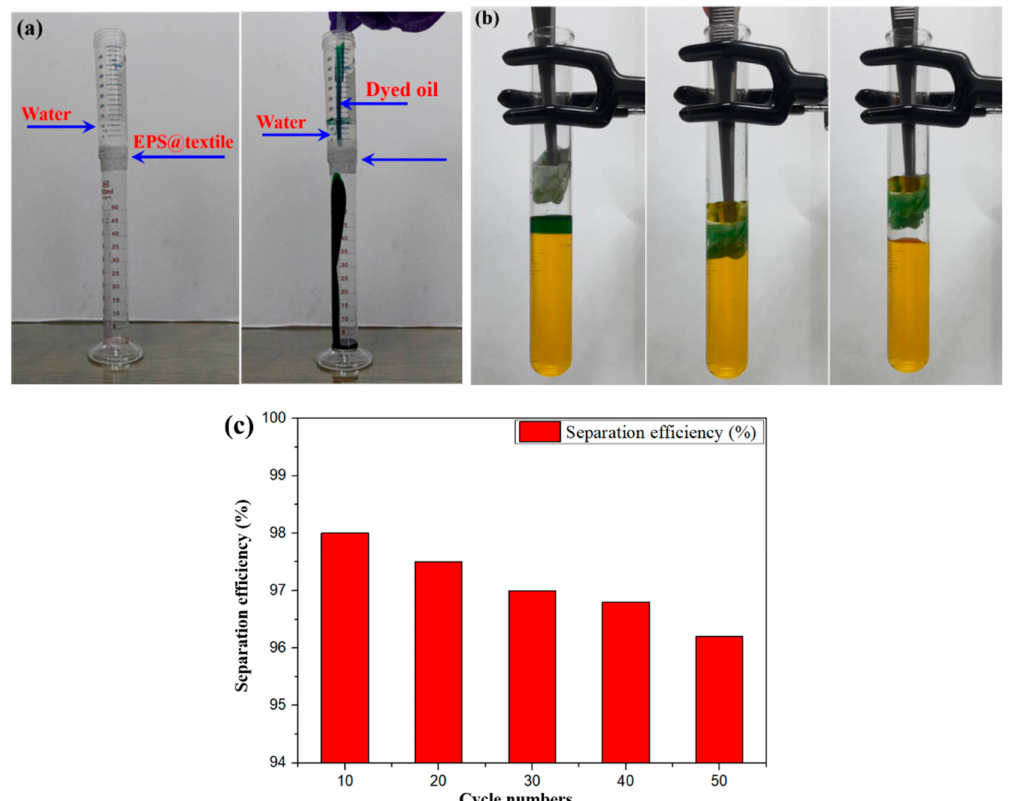
Figure 4. The optical photographs of oil/water separation using a fabric coated with EPS@textile as ( a ) filtering membrane and ( b ) adsorbent; ( c ) durability test of separation efficiency using